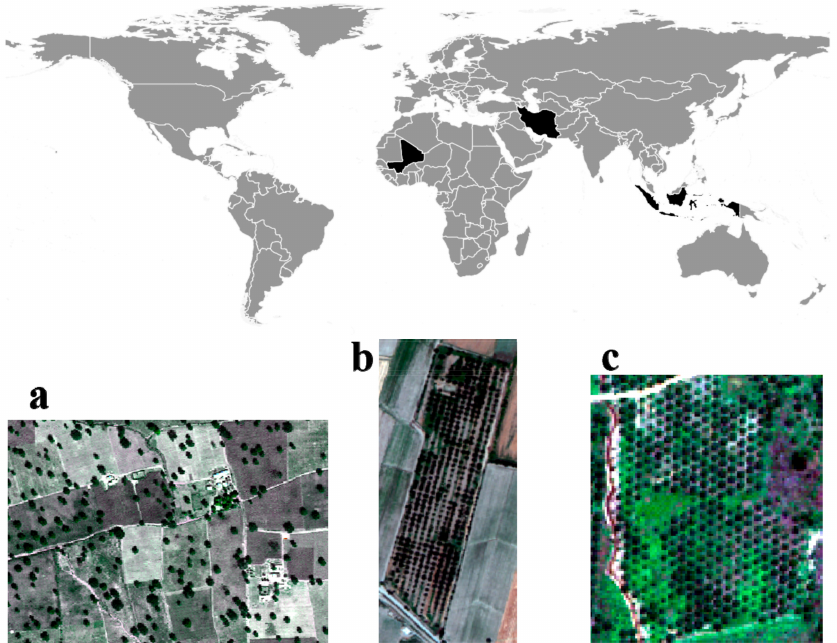
Figure 5. Three orchards at di ff erent locations displayed as true color composite from satellite images. ( a ) Vitellaria trees in Mali; ( b ) Walnut trees in Iran; ( c ) Oil palm trees in